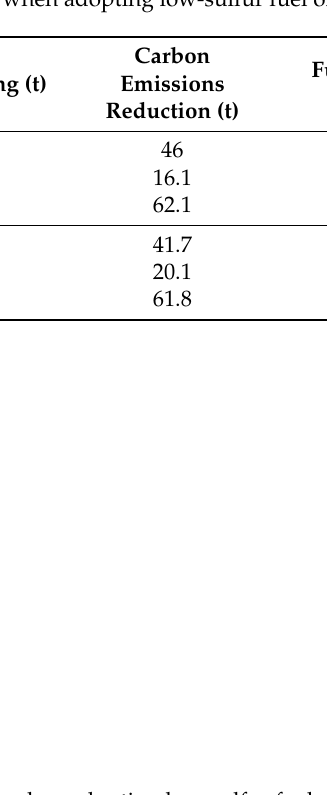
Figure 8. Fuel oil consumption of the whole voyage when adopting low ‐ sulfur fuel oil.